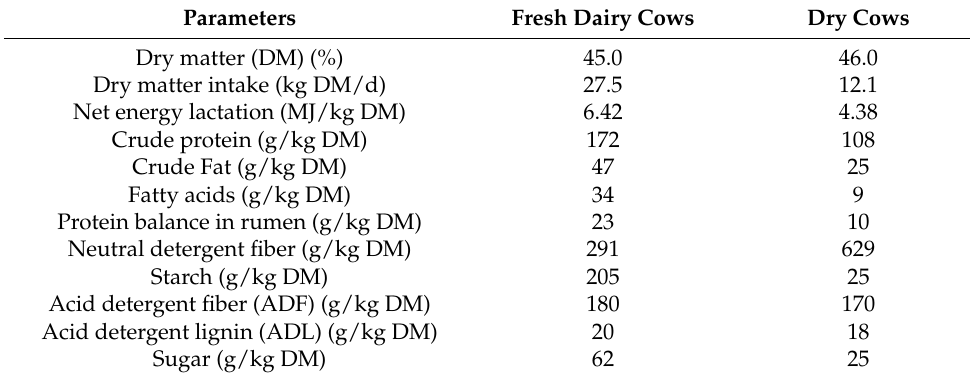
Table 2. Chemical composition of feeding rations for dry and fresh dairy